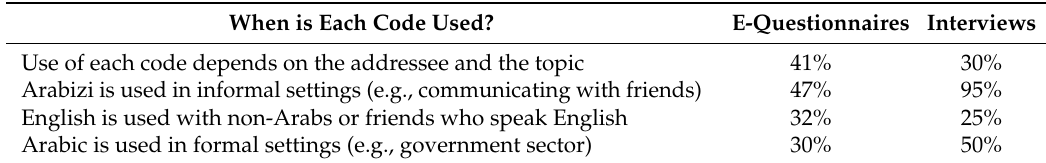
Table 3. The reasons for code-switching between Arabizi, Arabic, and